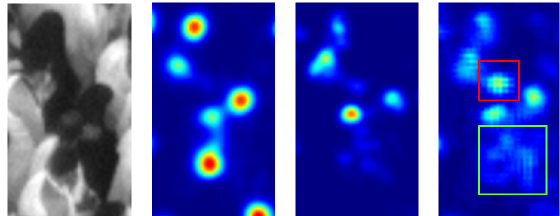
Figure 7. From left to right: ( a ) Example of an image patch (with increased contrast for clarity) with ( b ) associated output map of CNN-ensemble Fusion, i.e., BetP ( H ) , ( c ) ignorance map (proposed) and ( d ) traditional standard deviation map respectively. Failure cases of standard deviation map are highlighted in red and green